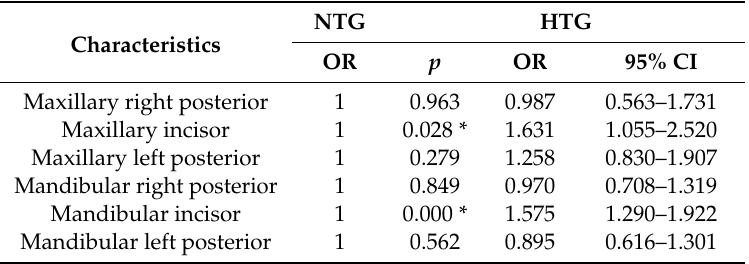
Table 4. CPI by triglyceride